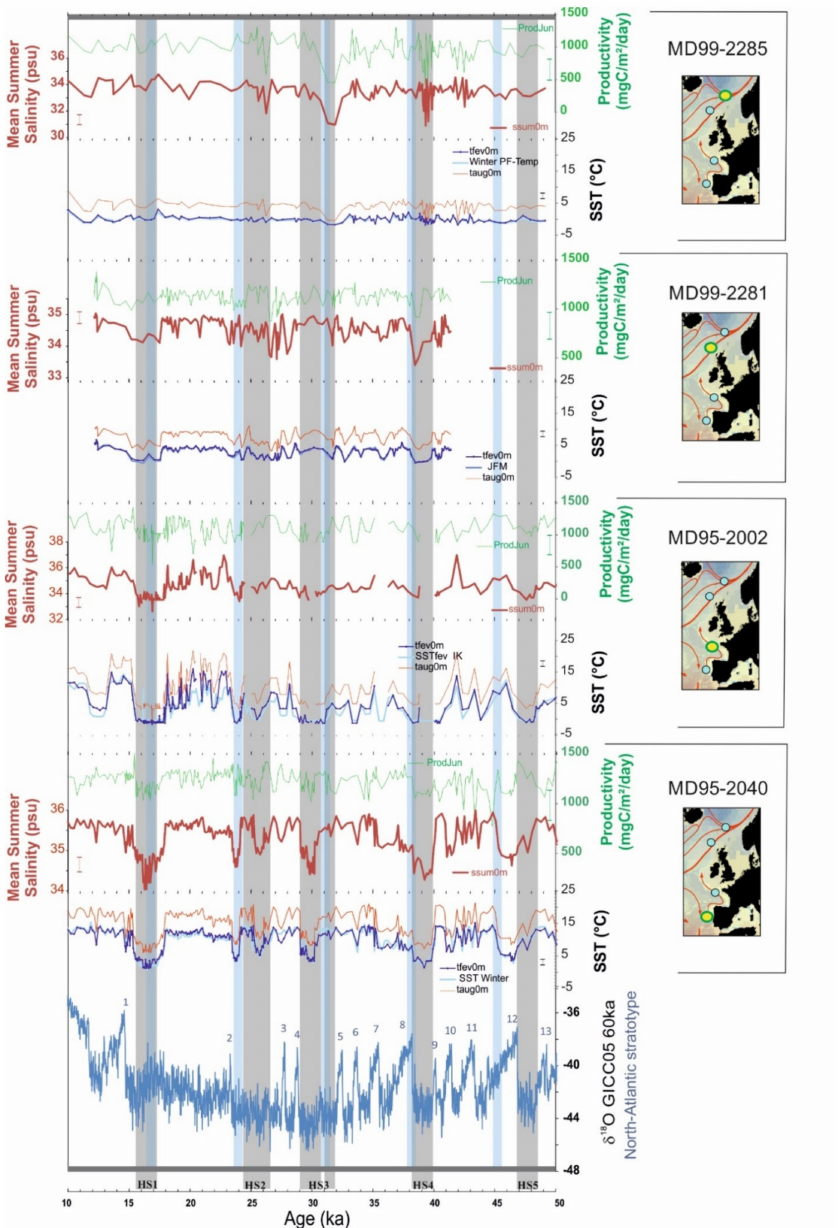
Figure 4. Comparison along the 50–10 ka interval of the newly reconstructed parameters (SSTs at 0 m for August and February; salinities at 0 m as summer means; productivities in June) for each core. The North Atlantic stratotypical reference (i.e., NGRIP δ 18 O [46]) is also plotted to infer abrupt climate changes along the period; the stratigraphical positions of the main cold events as documented in Figure 3 are also represented by vertical bands. The most recently published data for winter SSTs (JFM mean from Voelker and de Abreu, 2011 [32], for core MD95-2040; February mean for core MD95-2002; JFM mean from Wary et al., 2015 [21], 2017 [43]; see Table 1 for details) are shown for comparison. Note the exact correspondence among the reconstructed values, despite the new extraction of hydrographical parameters and the not-always-identical transfer function/calculation methods. For color used in this figure, the reader is referred to the Web version of this